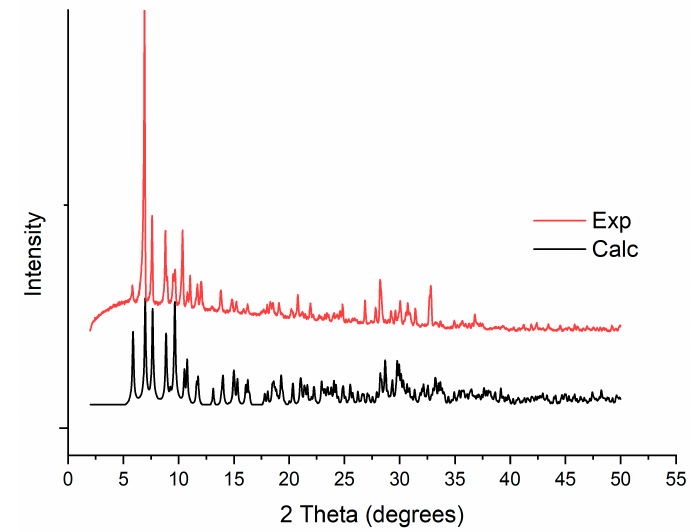
ff raction pattern of Na-1